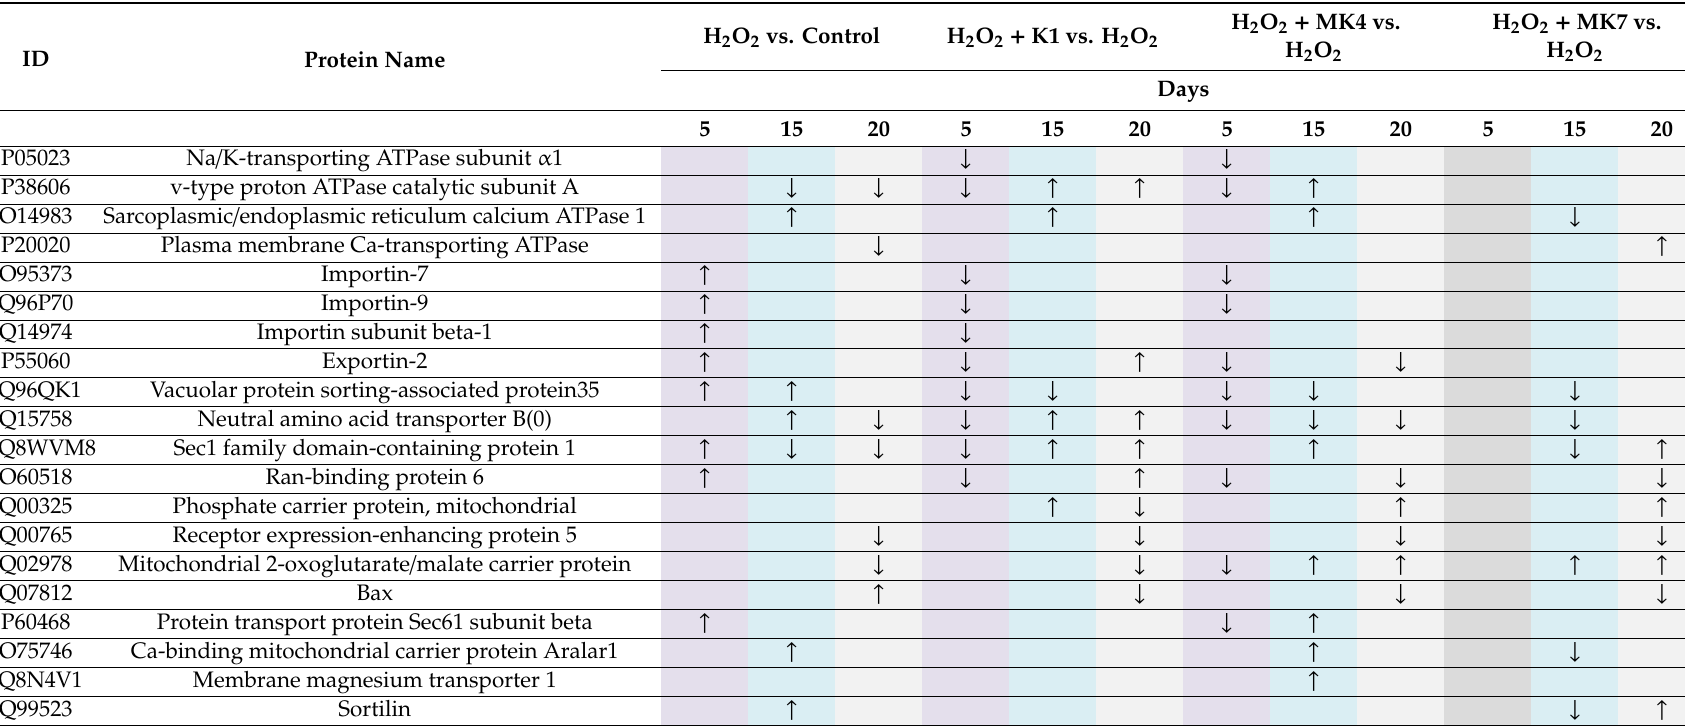
Table 1. The list of proteins with transporter activity that expression was significant changed in osteoblasts treated with H 2 O 2 (200 µ M for 24 h) and K1, MK4, or MK7 (10 µ M for 5, 15, and 20 days). Arrows indicate the direction of statistically significant changes for individual proteins ( ↑ —upregulation, ↓ —downregulation). Mean value of three independent experiments with standard deviation (SD) for each protein are presented in Tables